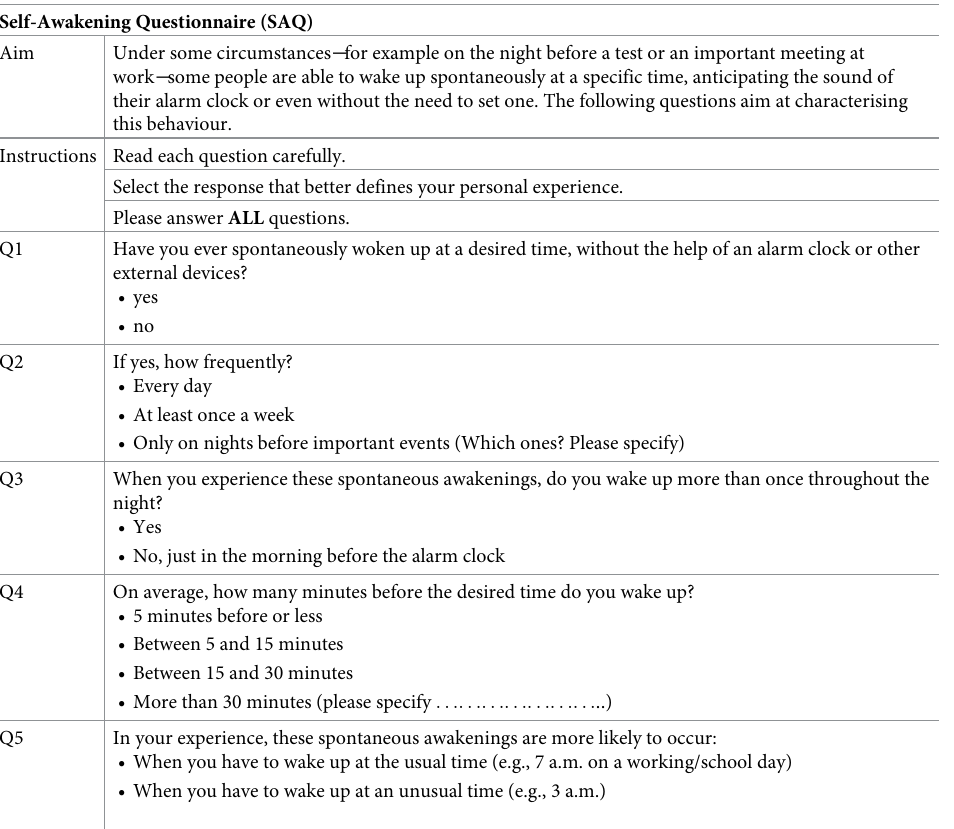
Table 1. Self-Awakening Questionnaire (English version). The questionnaire consists of five questions aiming at probing the ability of a subject to wake up spontaneously (Question 1), and accurately (Question 4), independently from habit or circadian preference (Question 2, Question 5), or underlying conditions (e.g., stress, anxiety; Question